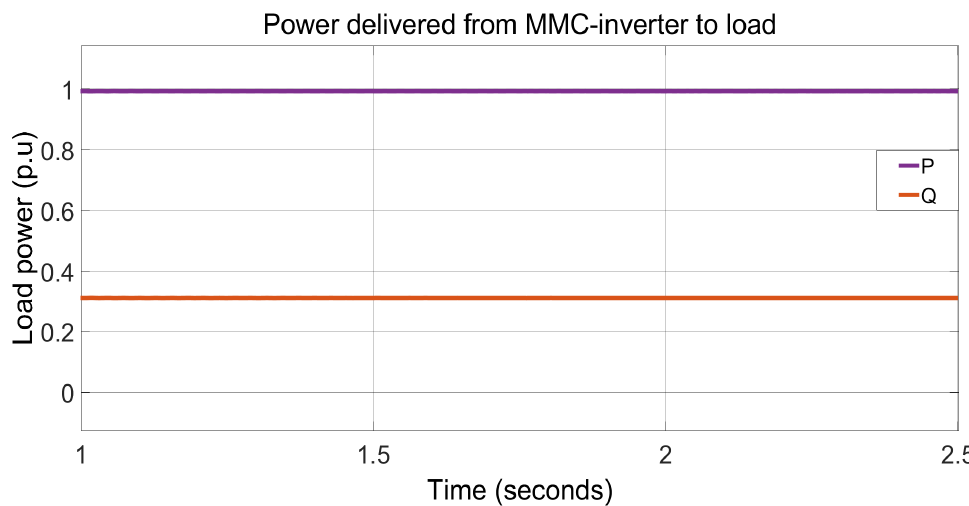
Figure 24. Power delivered from MMC-inverter to load distribution system.